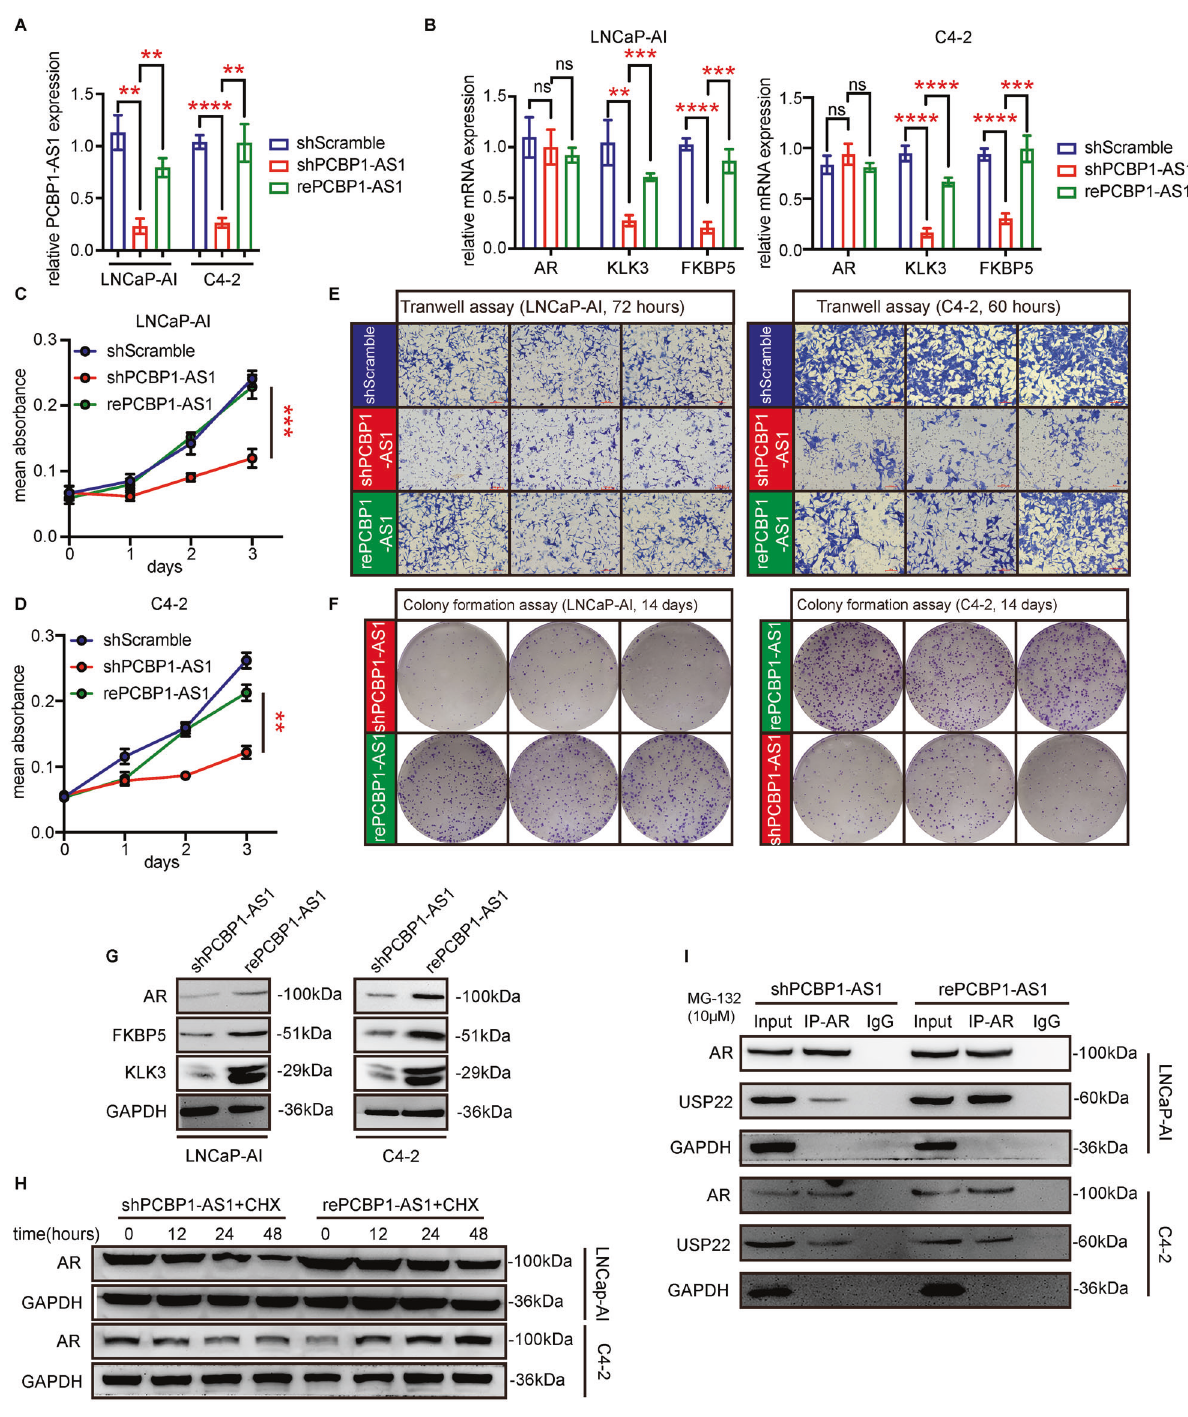
Fig. 4 Rescue PCBP1-AS1 recover cell phenotypes and AR-USP22 complex stability. A PCBP1-AS1 rescue ef fi ciency. GAPDH was used as a control. B AR, KLK3, FKBP5 RNA expression in indicated groups. C , D Cell viability detection using MTT in indicated groups. E Cell migration ability detected by Transwell assay in indicated groups. F Cell proliferation ability detected by colony formation assay in indicated groups. G AR, KLK3, FKBP5 protein expression before and after PCBP1-AS1 rescue. H AR degradation rate after CHX addition in indicated groups. I Co- IP was used to detect the binding ability between AR and USP22 in indicated groups. All experiments were repeated at least three times. Signi fi cance: * P <0.05, ** P <0.01, *** P <0.001, **** P